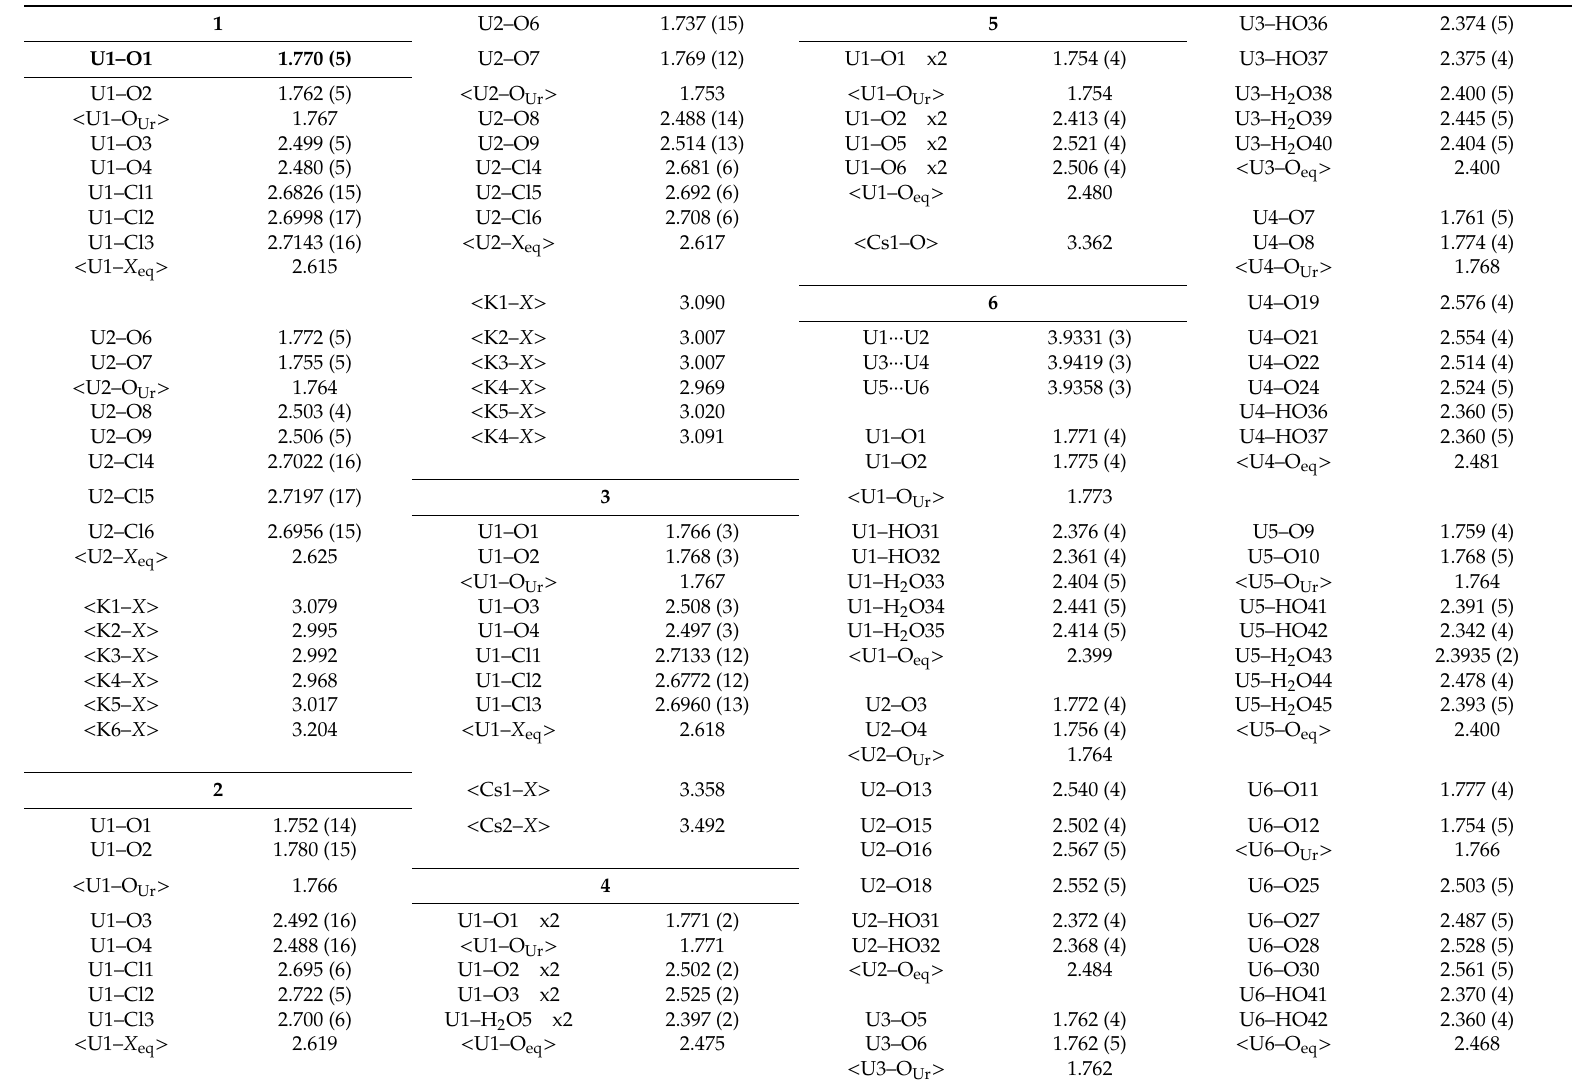
Table 2. Selected bond lengths (Å) in the structure of 1 – 6 ( X = O,